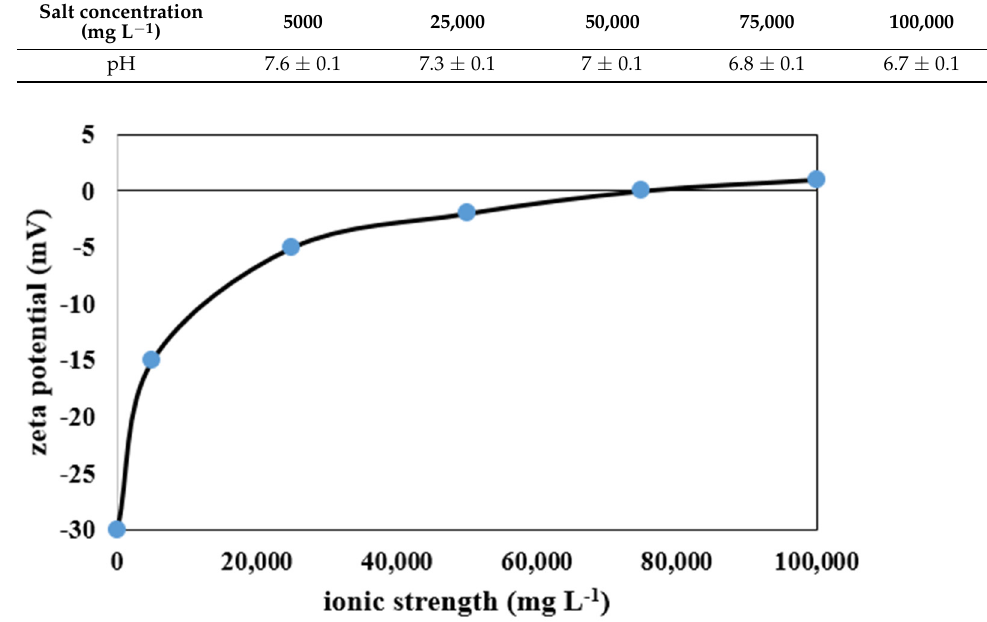
Figure 12. Effect of ionic strength on zeta potential of synthetic wastewater of desalter unit.